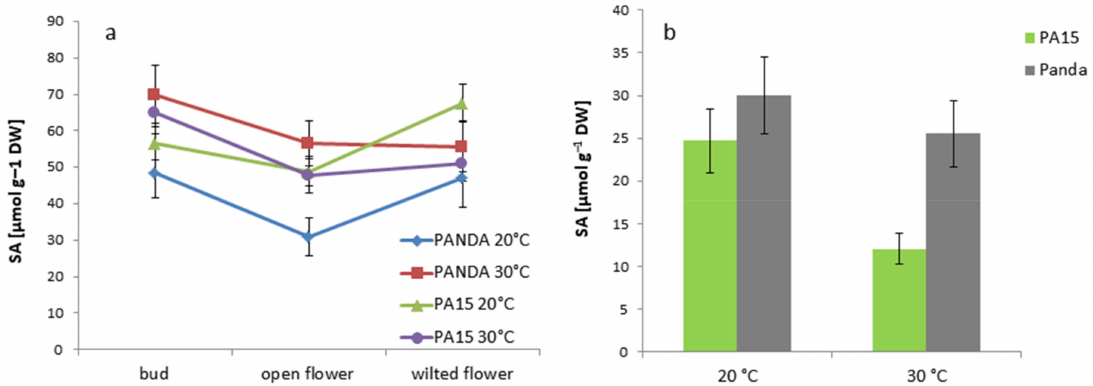
Figure 11. Content of SA [ µ mol g − 1 DW] in the flower buds, open flowers, and wilted flowers ( a ) and the leaves ( b ) of the ‘Panda’ and PA15 plants grown at 20 ◦ C (control) and 30 ◦ C (thermal stress). Means ( n = 3) ±